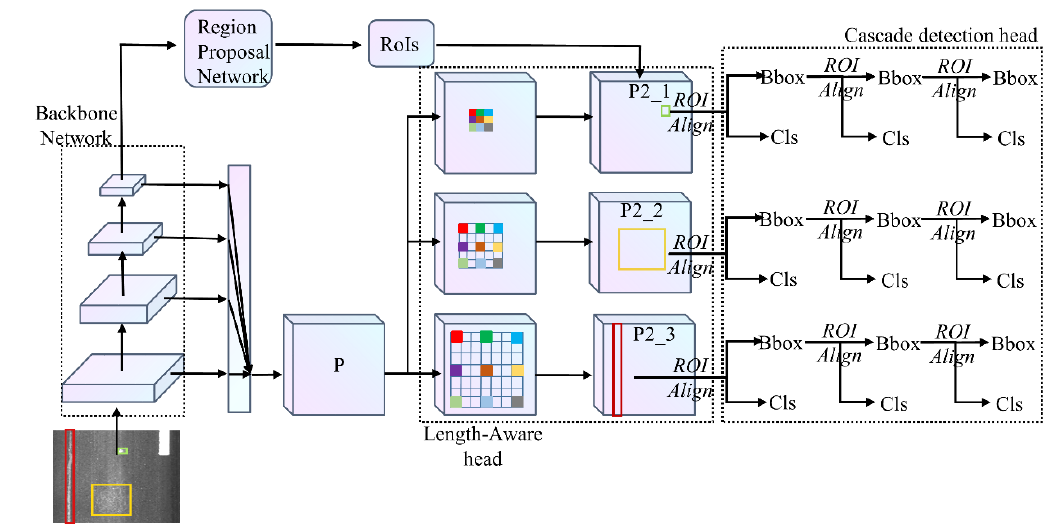
Figure 2. Overall architecture of CrdNet. High-resolution feature map P (stride of 4) denotes fused feature map of four stage output from backbone network. Three branches of length-aware head extract receptive fields to establish different range dependencies. Cascade detection head adaptively cascades to predict on the corresponding branch with respect to the length of regions of interest (ROIs).